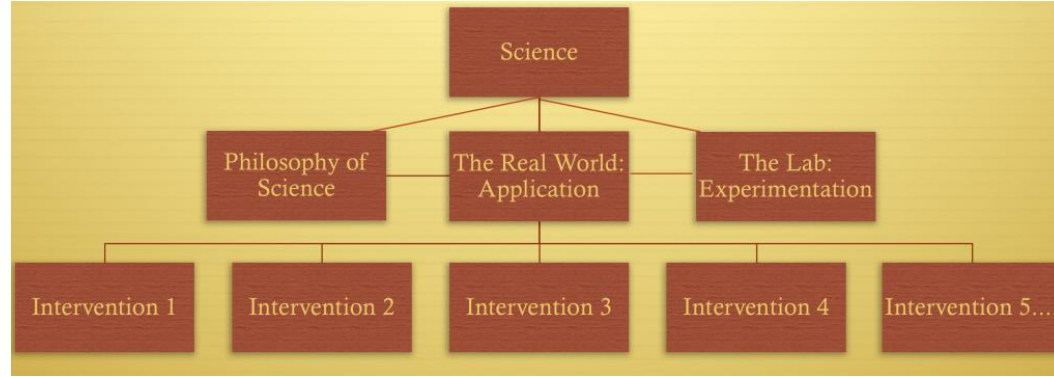
Figure 1. Avoiding category mistakes when distinguishing between science and interventions.